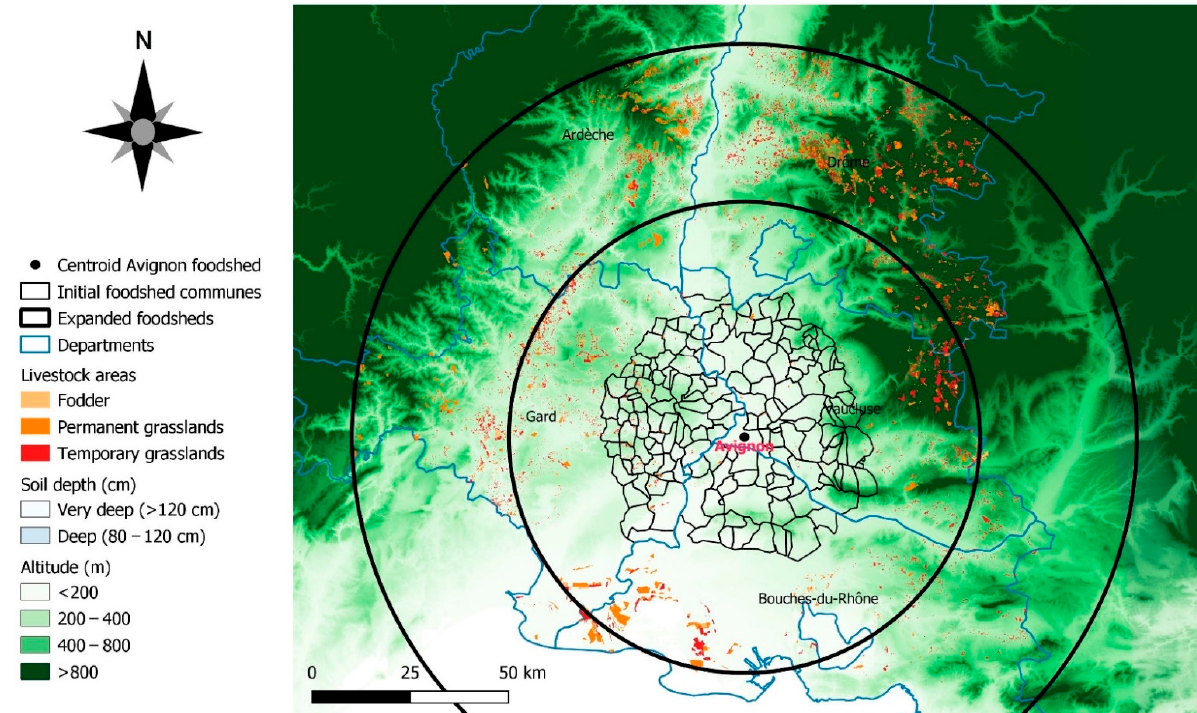
Figure 7. Current area used for extensive livestock farming in the five departments considered in the study ( blue ) in two radii around the city of Avignon: 60 and 100 km ( black bold ). Information on soil depth and altitude is also shown. Agriculture 2021 , 11 , x FOR PEER REVIEW